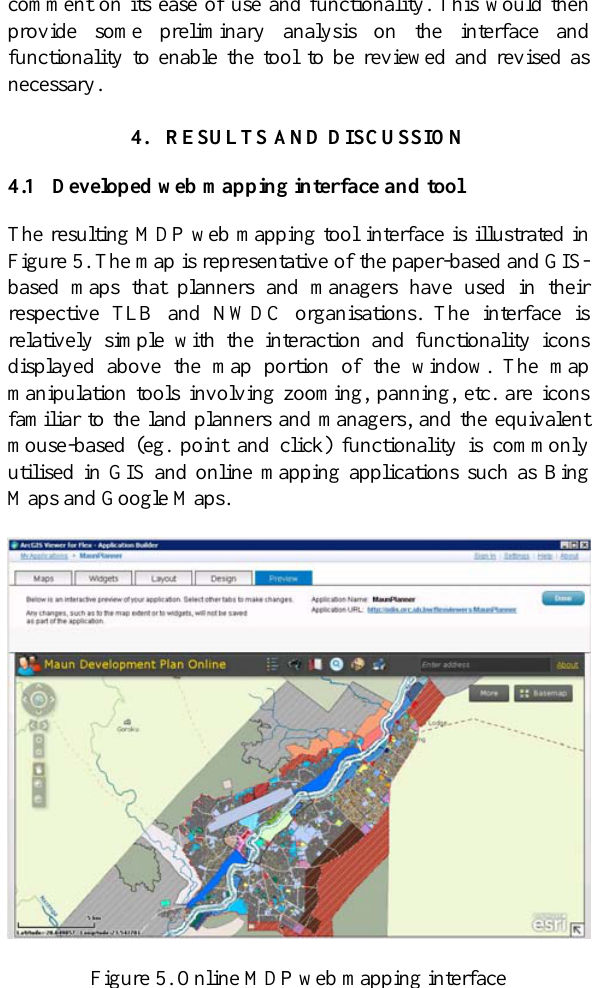
Figure 5. Online MDP web mapping